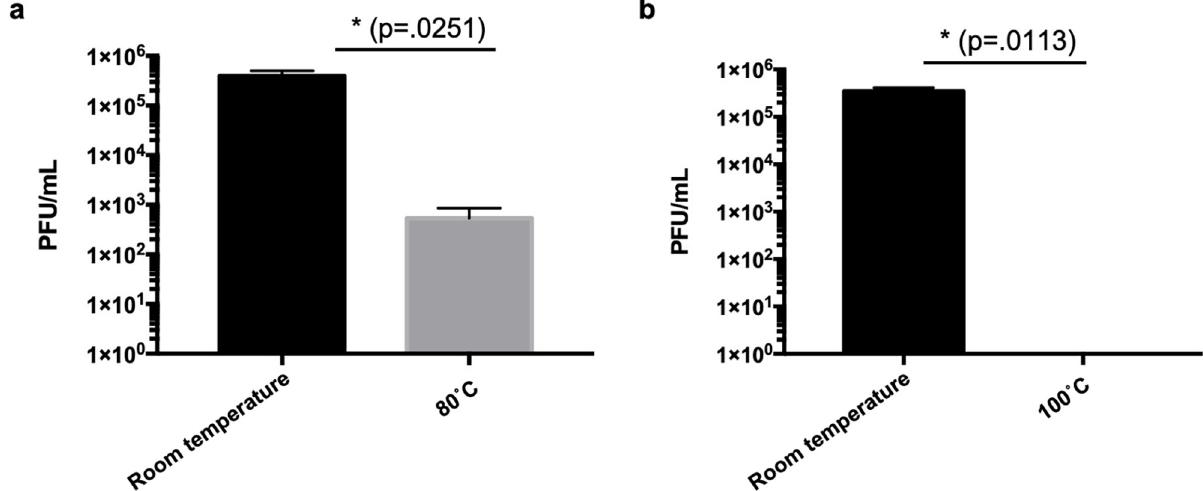
Fig 1. SARS-CoV-2 thermal stability on N95 respirator material. SARS-CoV-2 was inoculated onto N95 respirators and were subsequently subjected to either 80˚C of dry heat for 60 minutes or 100˚C of dry heat for 30 minutes.